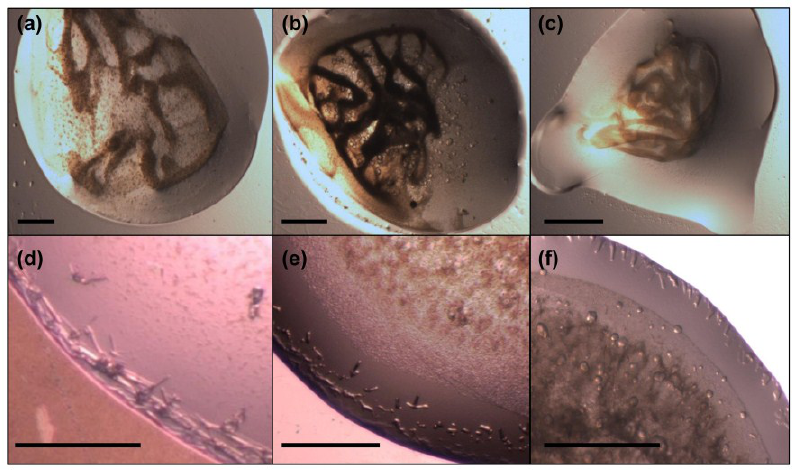
Figure 7. MdtM crystallization trials . Images in panels ( a – c ) recorded the results of crystallization trials performed with MdtM purified using the original, unoptimized protocol and crystallization buffers contained in the commercially available MemGold2 screening kit (Molecular Dimensions). Images in panels ( d – f ) represent the results of crystallization trials performed using the same conditions as those in ( a – c ), respectively, but with MdtM protein purified using the optimized purification protocol. Full details of the crystallization conditions are described in the text. Scale bars in ( a – c ) represent ~500 μm. Scale bars in ( d – f ) represent ~200